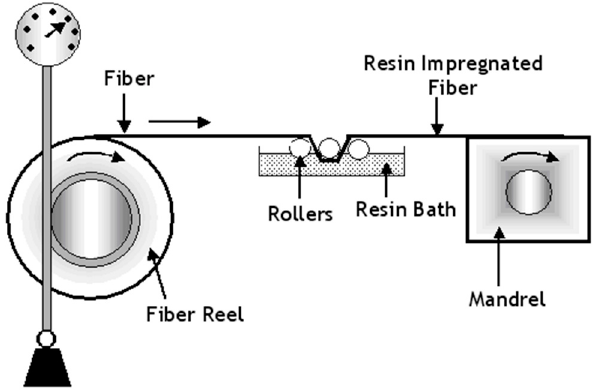
Figure 3. Schematic illustration of the production of pre-stressed composites using filament winding [36].